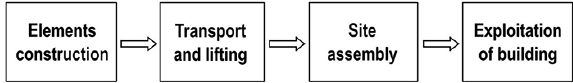
Figure 3. Construction phases of wood-framed large panel